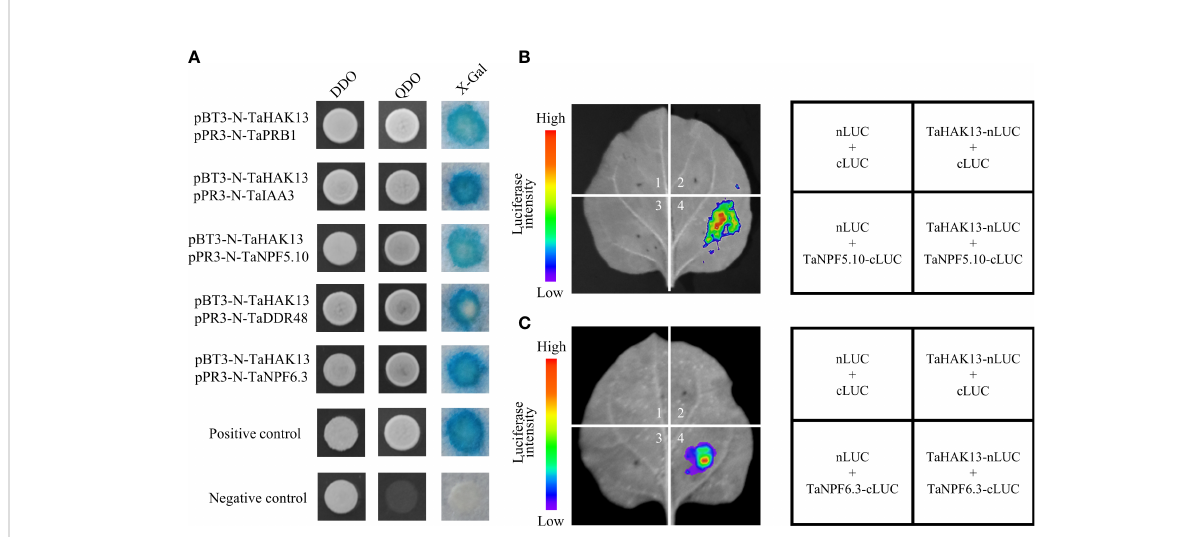
FIGURE 9 The interaction of TaHAK13 with TaNPF5.10 and TaNPF6.3. (A) The interaction of TaHAK13 with screened proteins was veri fi ed using a split- ubiquitin yeast two-hybrid system; different protein combinations were detected on appropriate screening media (SD/-L-T, SD/-A-/H/-L/-T, SD/-A/-H/-L/-T+20 m g/mL X-Gal). (B) LCA of the interaction between TaHAK13 and TaNPF5.10. (C) LCA of TaHAK13 and TaNPF6.3. As shown in the graphics, various combinations were used to co-transform tobacco leaves. Luciferase signals were captured by a NightSHADE LB 985 plant in vivo imaging